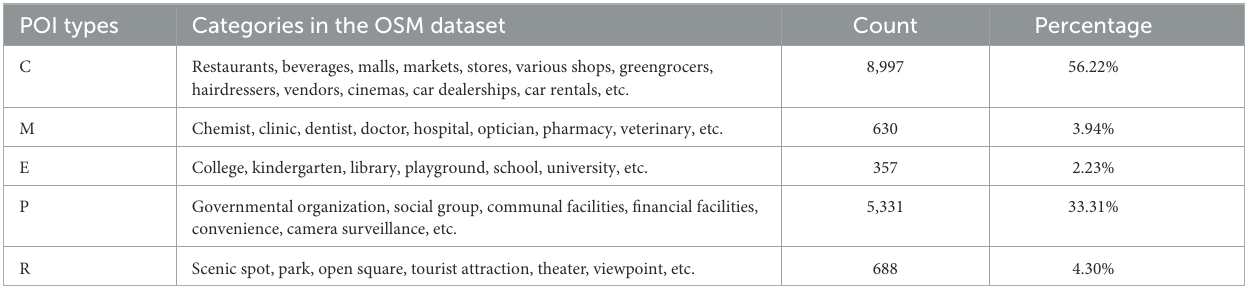
TABLE 1 Classification of POI types according to C · M · E · P · R and corresponding categories in the original OpenStreetMap (OSM) dataset. POI